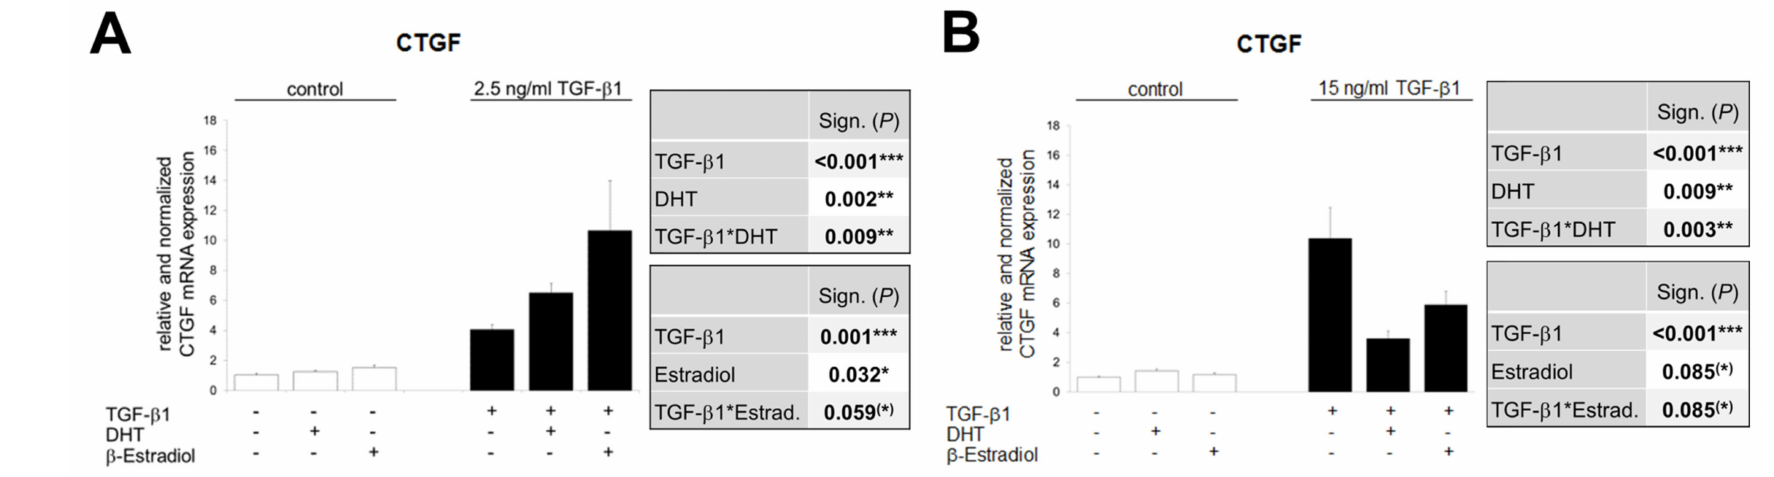
Figure 7. Real-time PCR analysis of mRNA expression in TGF- β 1-treated TKPTS cells. ( A ) Cells were stimulated for 24 h with control or 2.5 ng / mL TGF- β 1 and with or without sex hormones (DHT / β -estradiol), as indicated. CTGF mRNA levels were determined from duplicate samples in three independent experiments (yielding a total of n = 6 sample points). ( B ) Cells were stimulated for 24 h with control or 15 ng / mL TGF- β 1 and with or without sex hormones (DHT / β -estradiol), as indicated. CTGF mRNA levels were determined from triplicate samples in four independent experiments (yielding a total of n = 12 sample points). ( A , B ) The significances, shown in the upper table, were assessed using two-way ANOVA with TGF- β 1 (control or 2.5 or 15 ng / mL) and DHT as the two factors. The significances, shown in the lower table, were assessed using two-way ANOVA with TGF- β 1 (control or 2.5 or 15 ng / mL) and estradiol as the two factors. TGF- β 1, DHT, Estradiol: main e ff ect of TGF- β 1 / DHT / Estradiol, respectively. TGF- β 1*DHT, TGF- β 1*Estradiol: interaction (determines whether the one main e ff ect depends on the level of the other main e ff ect). * P ≤ 0.05; ** P ≤ 0.01; *** P ≤